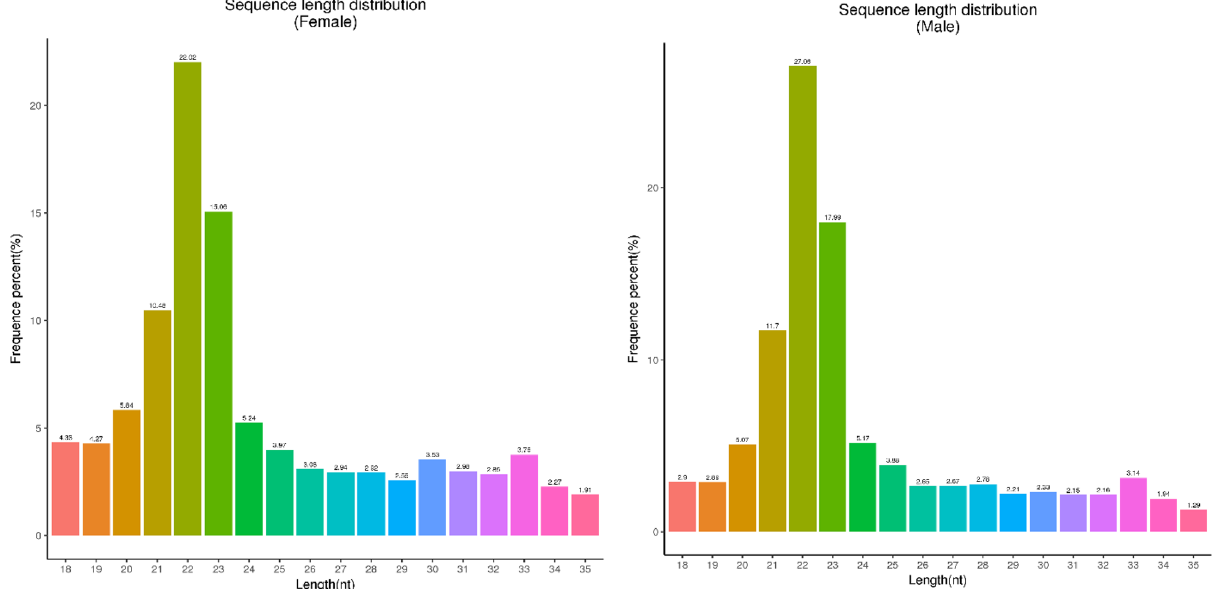
Figure 2. Length distribution of small RNA sequences in the XX (left) and XY (right) gonads of T. rubripes